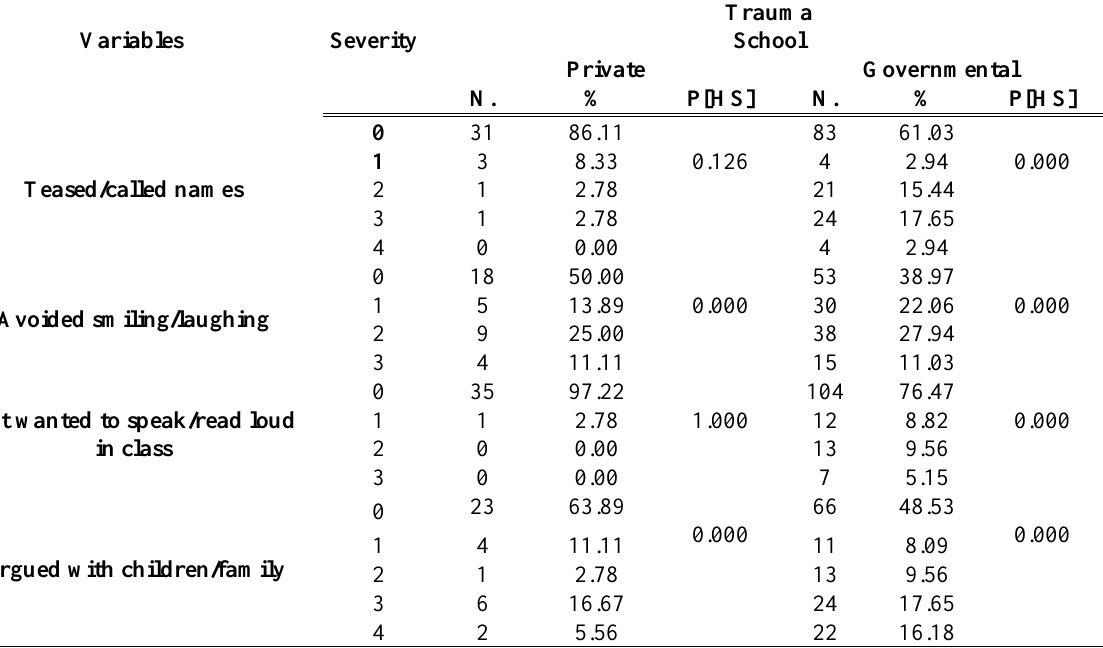
Table (4d): The association of traumatic dental injuries and quality of life regarding social well- being by school